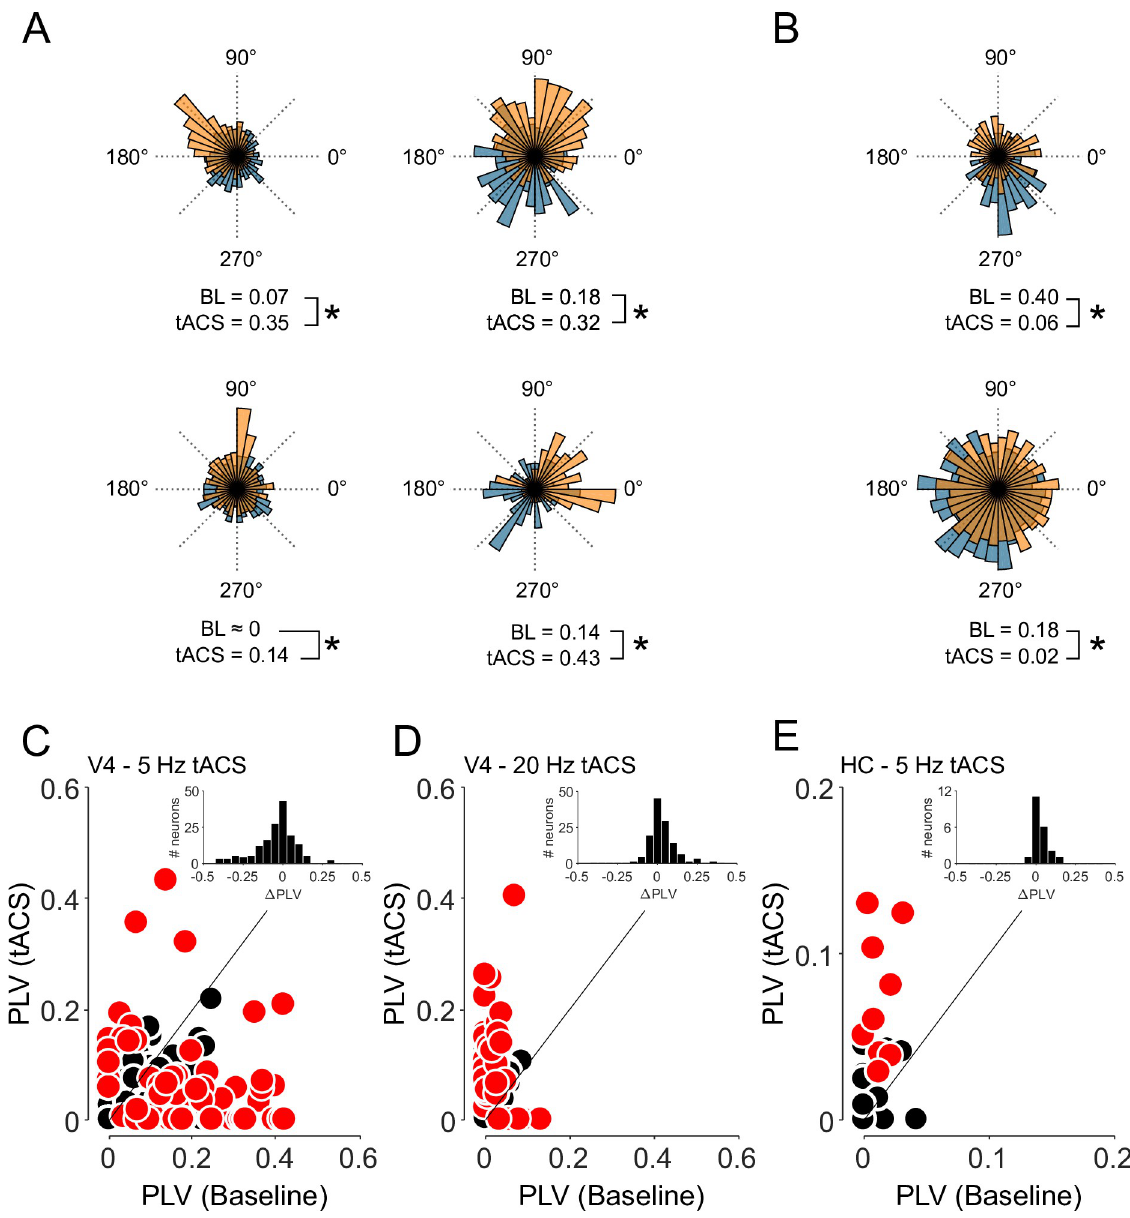
Fig 1. Applying tACS during physiological oscillations results in bidirectional changes in spike timing. (A, B) Spike density histograms for 6 example V4 neurons showing the relative amounts of spiking across an oscillatory cycle. The cells in (A) showed increased entrainment during tACS (orange), compared to baseline (blue). This was sometimes (right column), but not always (left) accompanied by a shift in preferred spiking phase. However, many more neurons, like those shown in (B), had decreased entrainment during 5 Hz tACS compared to baseline. PLV values for each condition are shown below; asterisks indicate p < 0.01. (C–E) Each point in the scatter plots represents a neuron’s PLV during baseline (horizontal position) and tACS (vertical). Data were collected (C) in the presence of a 5 Hz ongoing oscillation within V4 ( N = 157), (D) also in V4, but at 20 Hz, where the oscillation is weaker ( N = 123), and (E) again at 5 Hz but in the hippocampus (HC; N = 21), which also lacks strong 5 Hz oscillations under our conditions. Neurons showing individually significant changes in phase locking are denoted in red ( p < 0.05; per-cell randomization tests). Inset histograms show the changes in PLV across the population. Moreover, 28/123 cells in panel D were also reported in (9); panel E adapted from (8). See also S1 Fig for comparison of entrainment during baseline conditions and S1 Data for numeric values. BL, baseline; PLV, phase-locking value; tACS, transcranial alternating current stimulation.